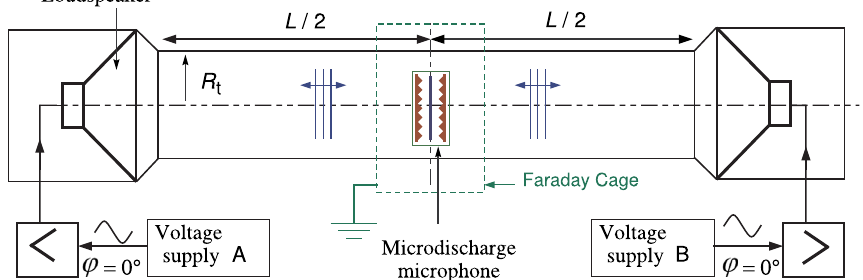
Figure 5. Experimental device used to control the sound pressure at the center of the tube. The sound pressure is fi rst measured with a reference microphone and then with a microplasma microphone. A Faraday cage is placed around a part of the waveguide. L = 455 mm and R t = 21.9 mm.